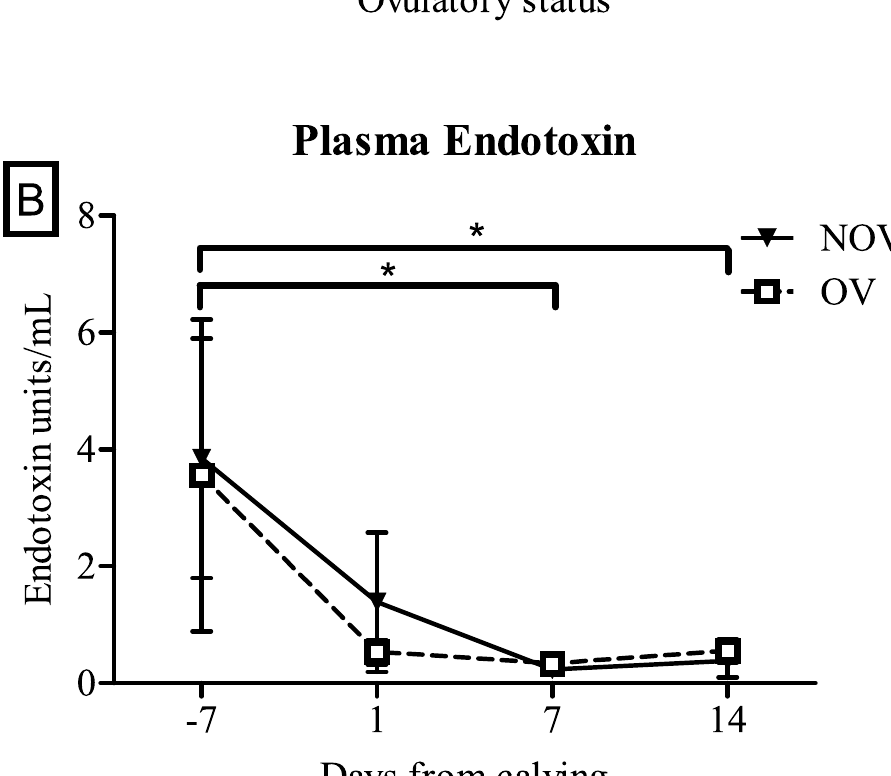
Fig 1. Endotoxin levels in follicular fluid and in circulation. A) Endotoxin levels in follicularfluid were higherin NOV cows comparedwith OV cows (n = 43, * = P < 0.05). B) Plasma endotoxinlevels were not different between NOV and OV cows but were higher ( * , P < 0.05) on day 7 prepartumcomparedwith day 7 and 14 postpartum.